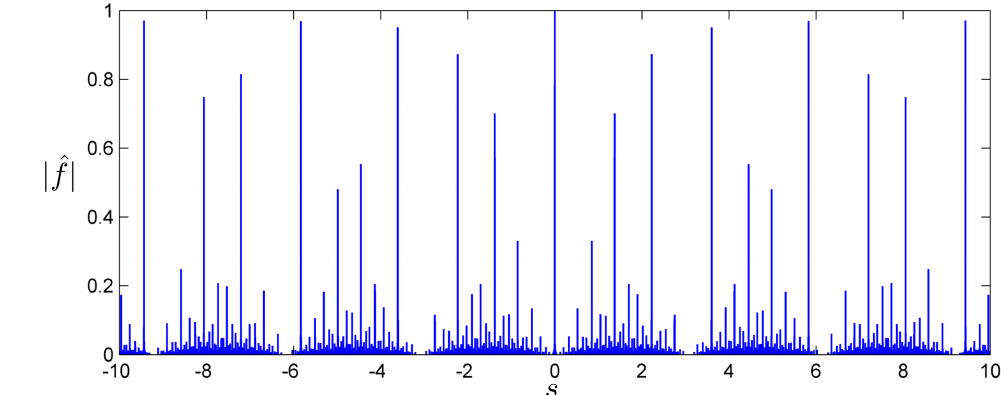
Figure 1. Normalized FT (magnitude) of a Fibonacci lattice with 4181 points. The reciprocal space s region 10 10 has been sampled at 100,001 points. − ≤ ≤